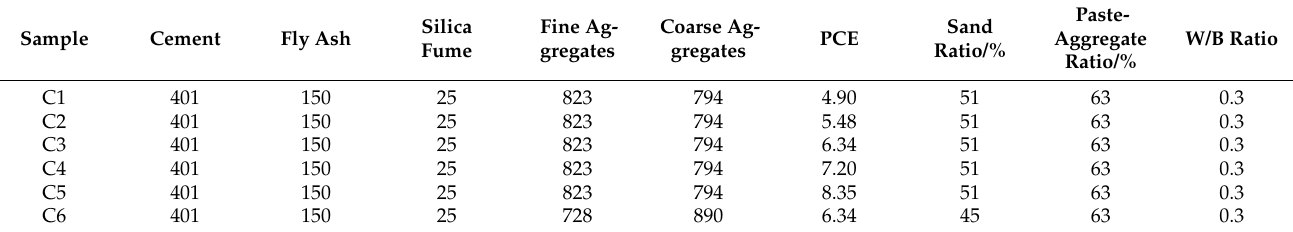
Table 2. Mix proportions of concrete (kg/m 3